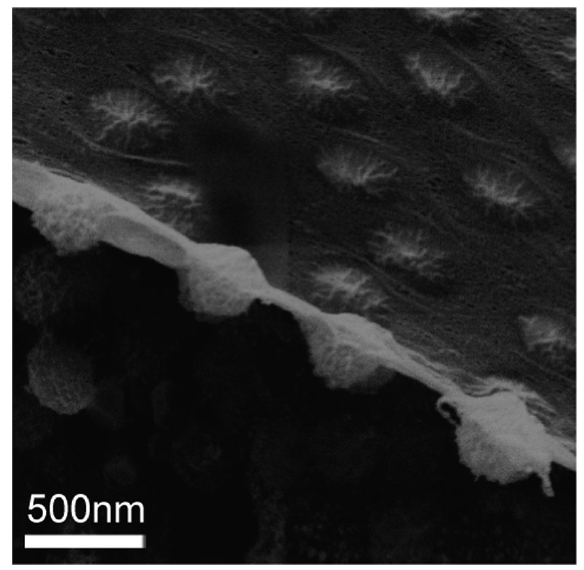
Figure 14. PNIPAM particles at an oil–water interface, imaged using cryo-SEM. Taken from